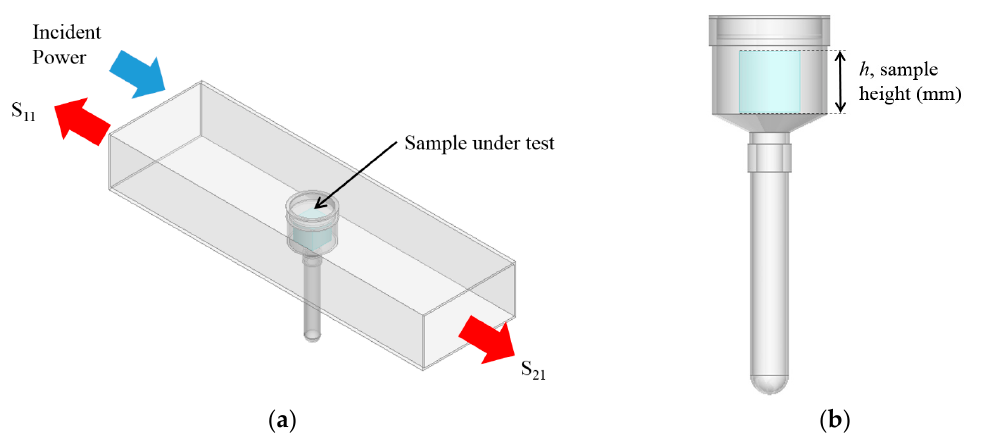
Figure 1. ( a ) A 3D model of the cavity designed for this work; and ( b ) the modelled EZ-Driploss sample container which is used to hold meat samples during the measurement procedure.